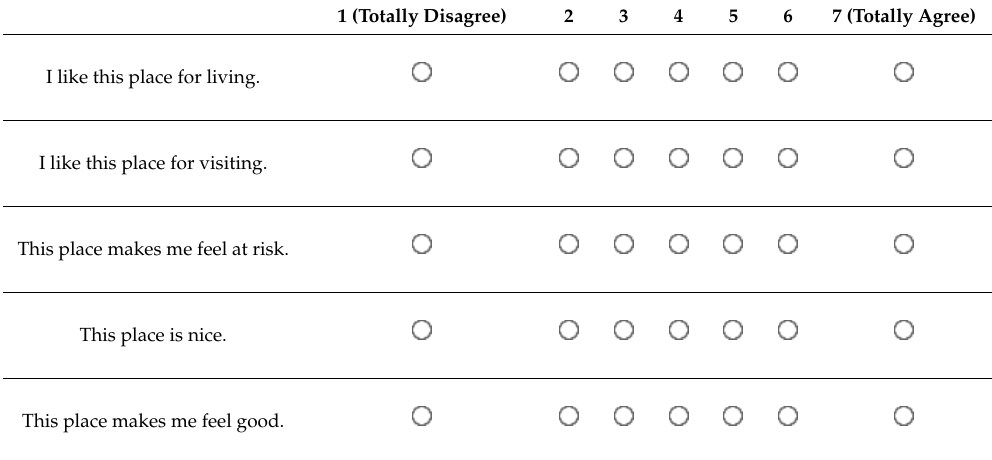
Figure A2. Google Earth aerial images used: ( A ) Freire, ( B ) Lumaco, ( C ) Pucón, ( D ) Curarrehue. (Scale of 1:10,000).